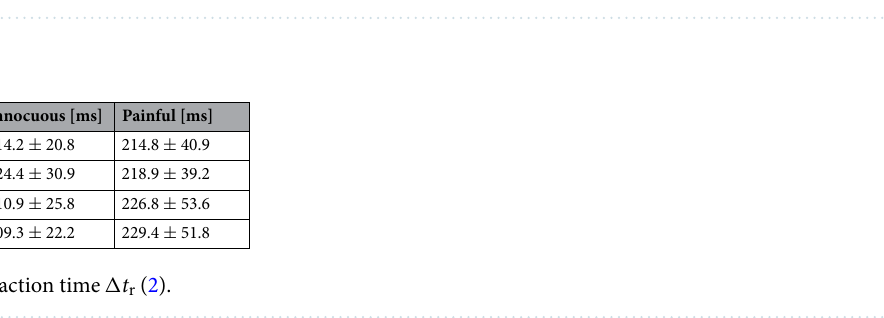
Table 1. Failure ratios f (3). a Note that, in the close 50% condition, errors were only possible when the obstacle was present.